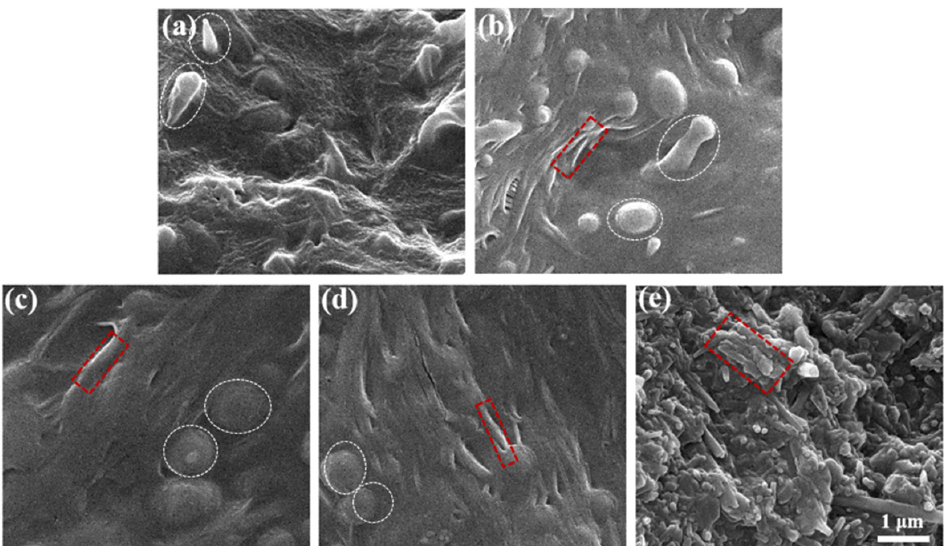
Figure 5. The SEM images of the cross-sections of the PEO/PBAT and PEO/PBAT/o-HNTs@AlPO 4 films. ( a ) PEO/PBAT, ( b ) PEO/PBAT/o-HNTs@AlPO 4 1, ( c ) PEO/PBAT/o-HNTs@AlPO 4 3, ( d ) PEO/PBAT/o-HNTs@AlPO 4 5, and ( e ) PEO/PBAT/o-HNTs@AlPO 4 7. The scale bar in the last image can be applied to the other images, and the inserted white dotted ellipses represent PBAT, and the inserted red dotted rectangles represent o-HNTs@AlPO 4 .